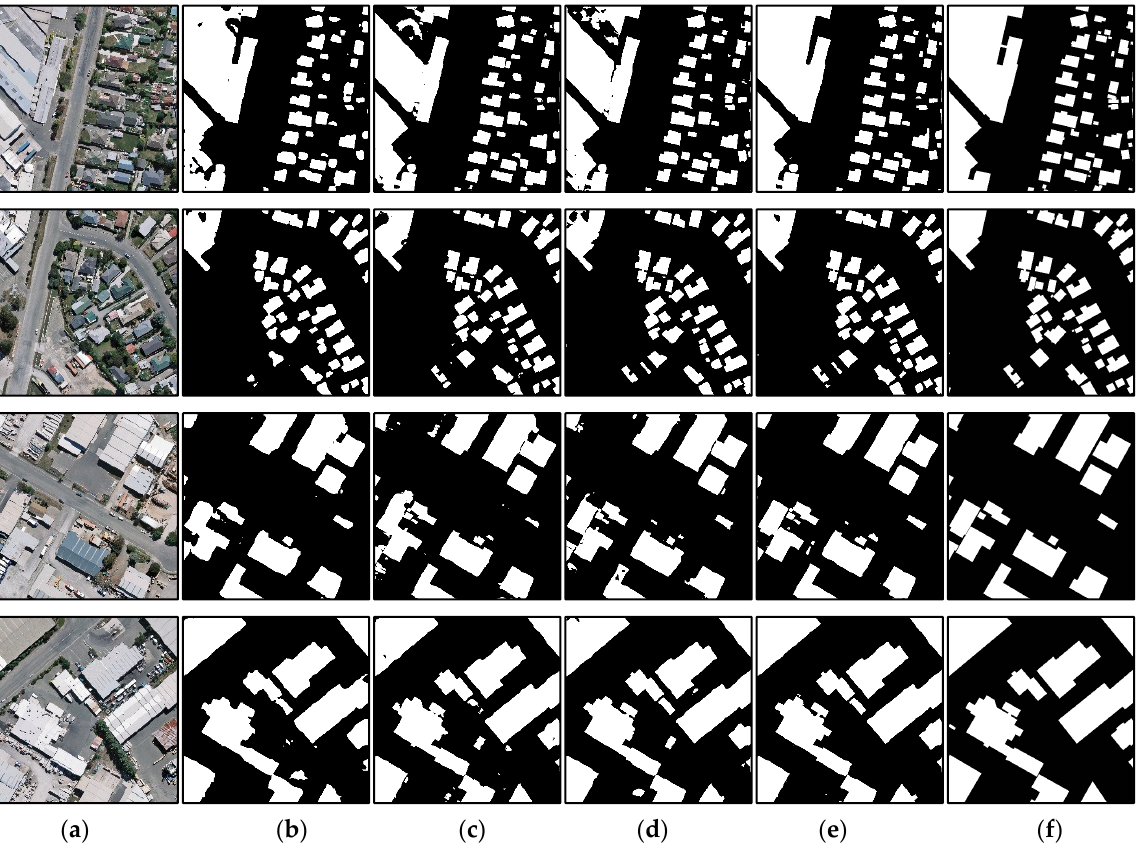
Figure 7. Visual comparisons of building-extraction results on the WHU building data set by different models. ( a ) Input image, ( b ) FCN, ( c ) Unet, ( d ) Deeplabv3+, ( e ) the proposed DMBC-Net, and ( f ) ground truths of the input image.